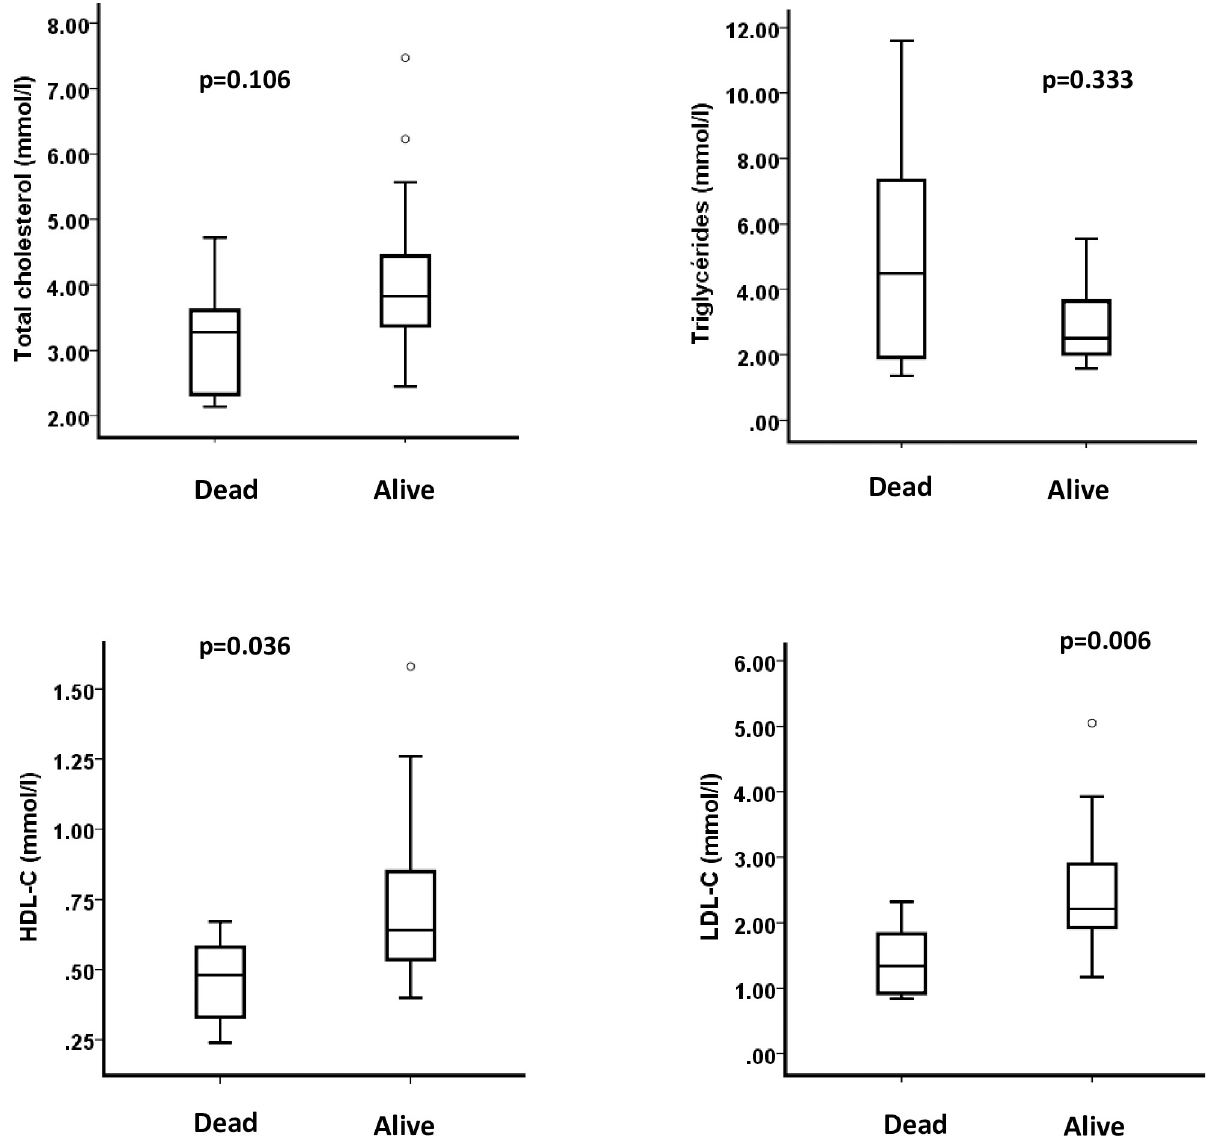
Fig 4. Relationship between total cholesterol, triglycerides, HDL-C and LDL-C concentrations on the day of the first VAP diagnosis and mortality on day 28.